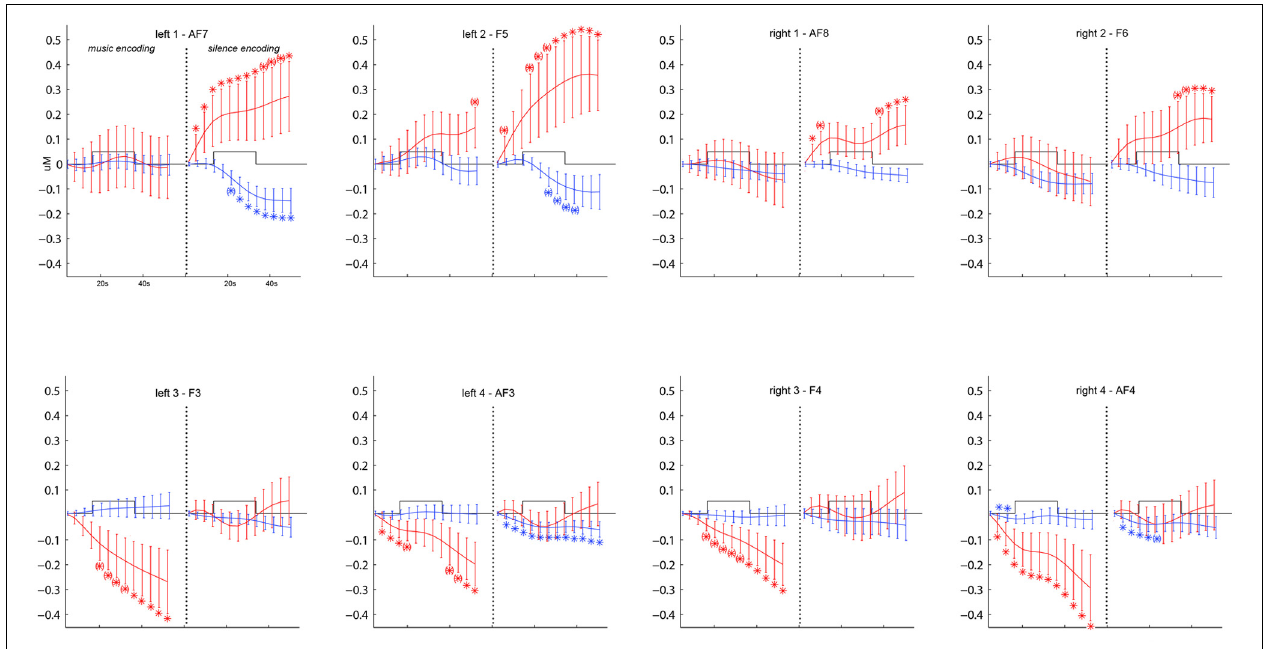
music (left side) conditions. * and (*) show, respectively, significant ( p < 0.05) and marginally significant (0.05 < p < 0.09) time points compared to baseline obtained by post hoc Fisher’s LSD